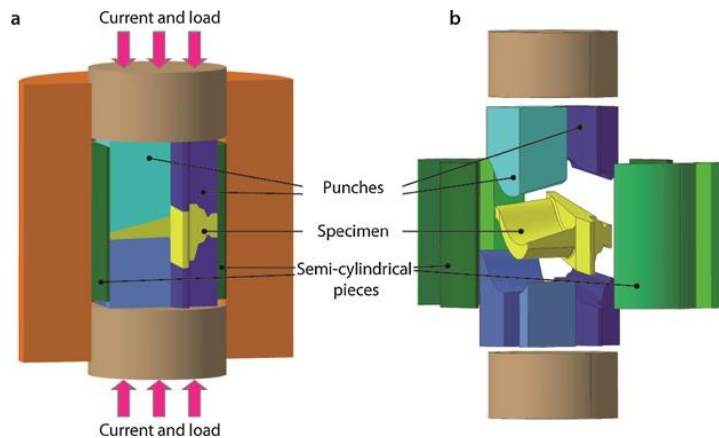
Figure 5. Representation of the graphite mold assembly with ( a ) punches in position and ( b ) side view of the mold, reproduced from [68], with permission from John Wiley and Sons, 2015.